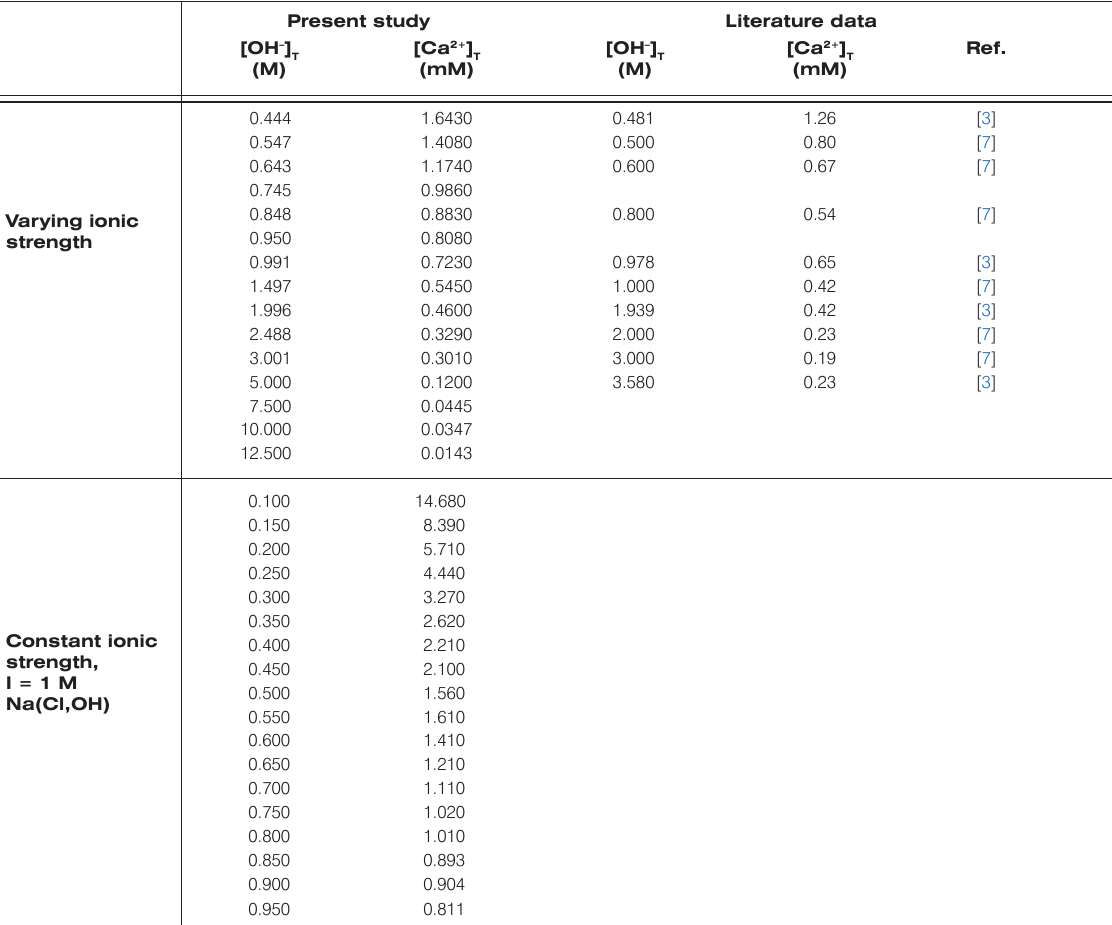
Table 1. Solubility of Ca(OH) in aqueous NaOH solutions at varying and at constant ionic strength, and at 25 o C. As solubility data were not 2 tabulated in [7], the values shown here are